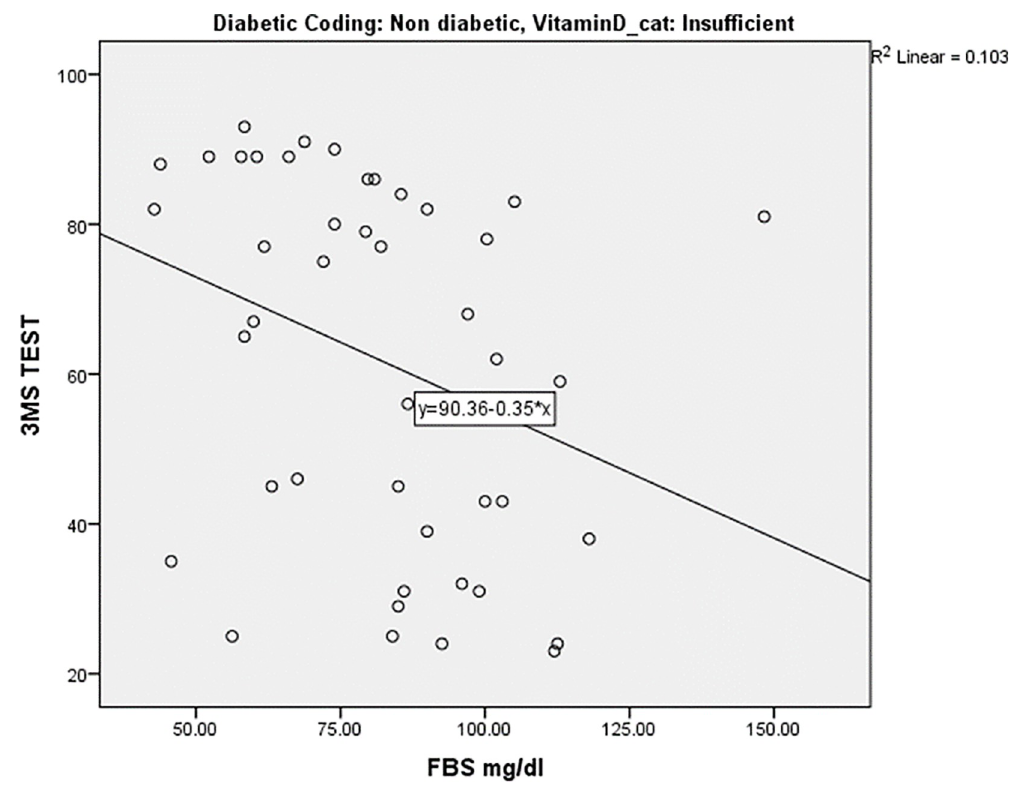
Fig 6. Correlation between 3MSE score and FBS in non-diabetics with vitamin D insufficiency.